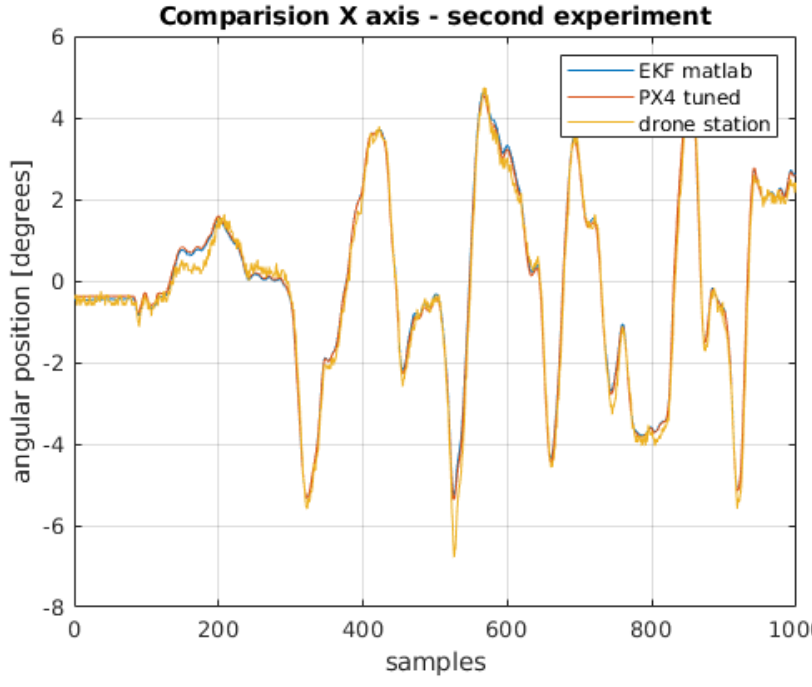
Figure 15. Comparison of angular position for X-axis.